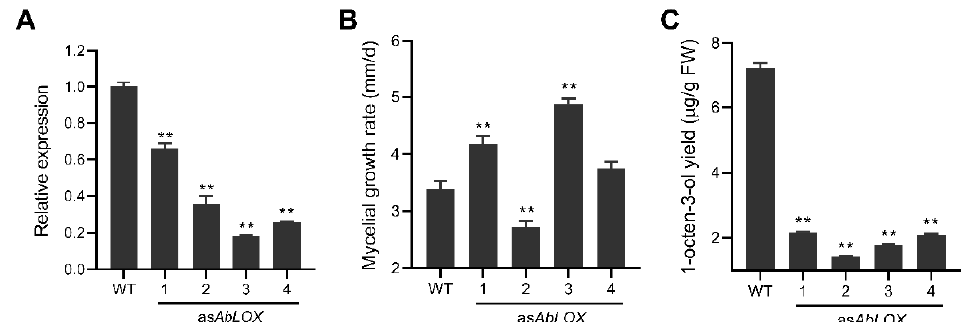
Figure 3. The Ab LOX expression ( A ), mycelial growth rate ( B ) and mycelial 1-octen-3-ol yield ( C ) of the antisense Ab LOX transformants derived from Agaricus bisporus . WT, The parent strain of A . bisporus As2796; as AbLOX -1 to asAbLOX -4, The antisense AbLOX transformants. Data marked with (**) were significantly different at p < 0.01 from WT based on one-way ANOVA.